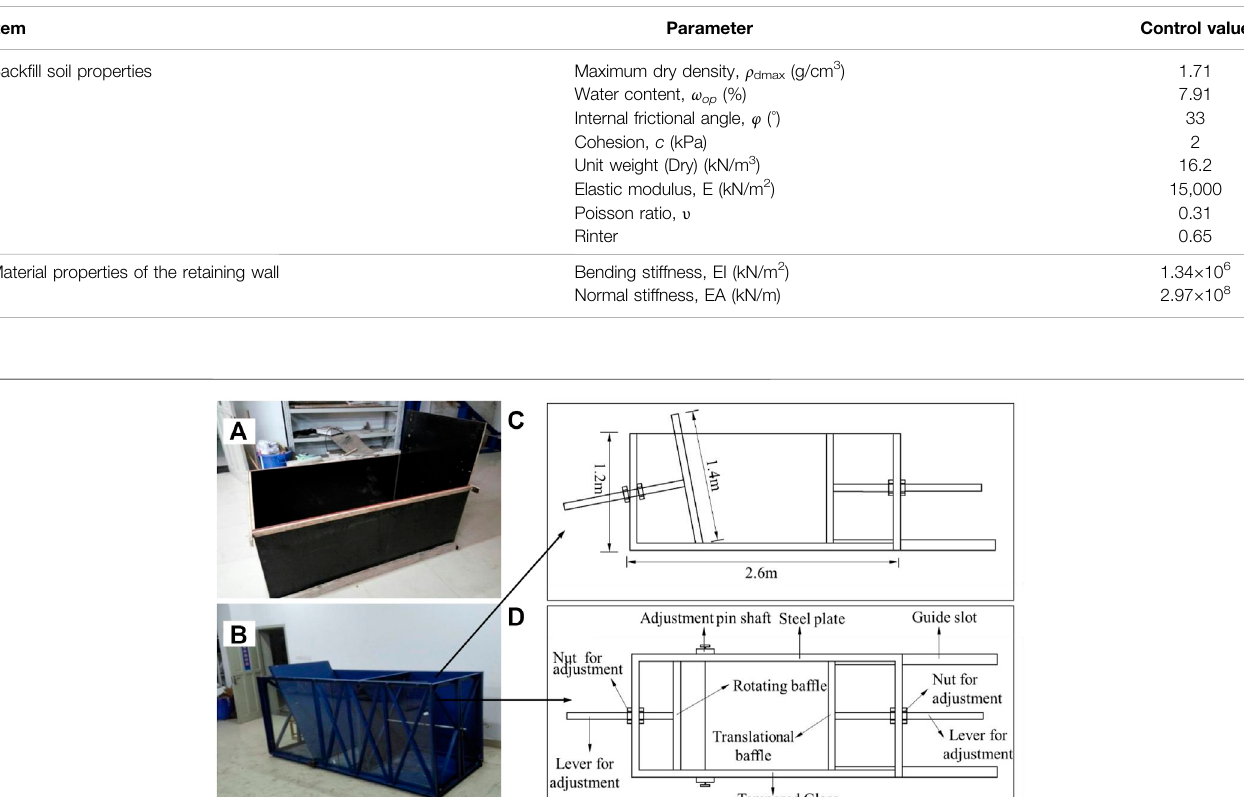
TABLE 1 | Properties of back fi ll sand and retaining wall.